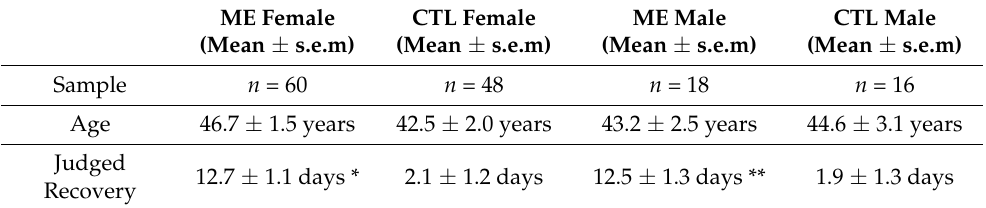
Table 1. Judged Recovery Time by Demographic Group.